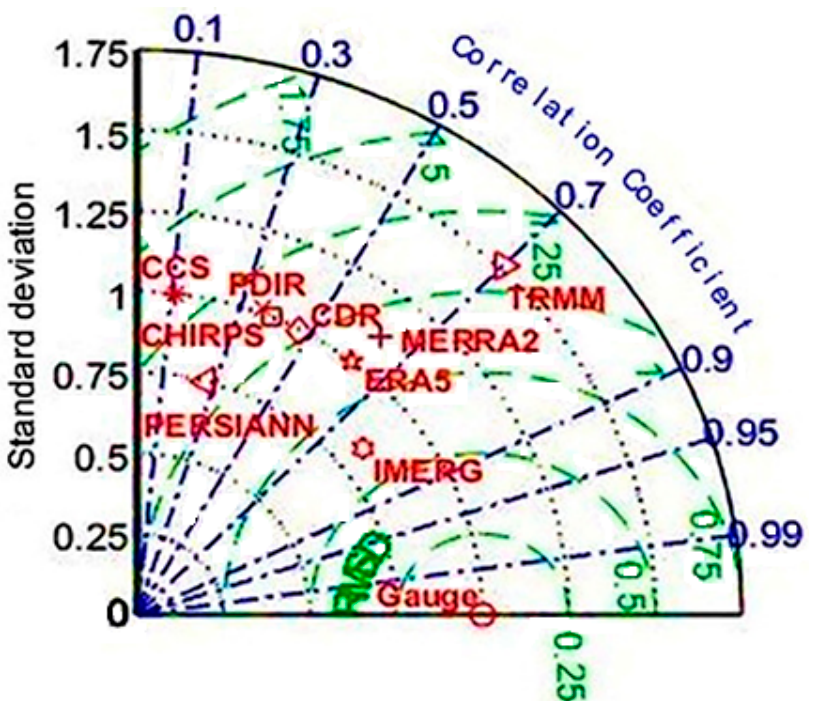
Figure 8. Taylor diagram illustrating the performance of daily estimates of the CCS, CDR, CHIRPS, ERA5, IMERG, MEERA2, PDIR, PERSIANN, and TRMM products.